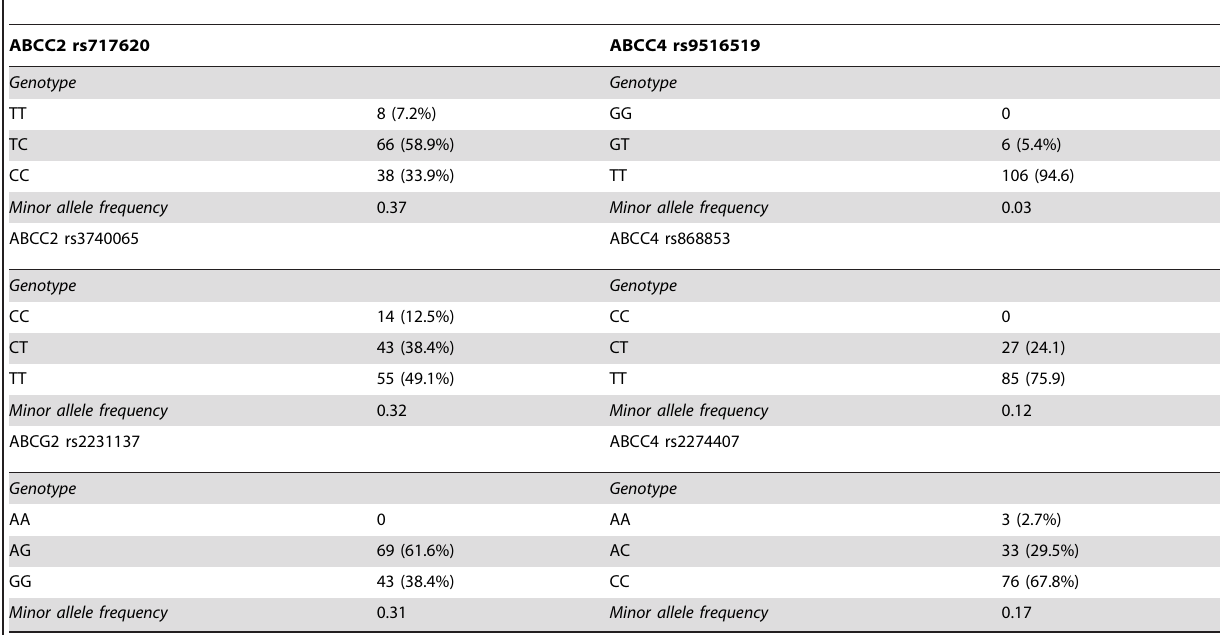
Table 2. Genotypes of selected single nucleotide polymorphisms in the patients.